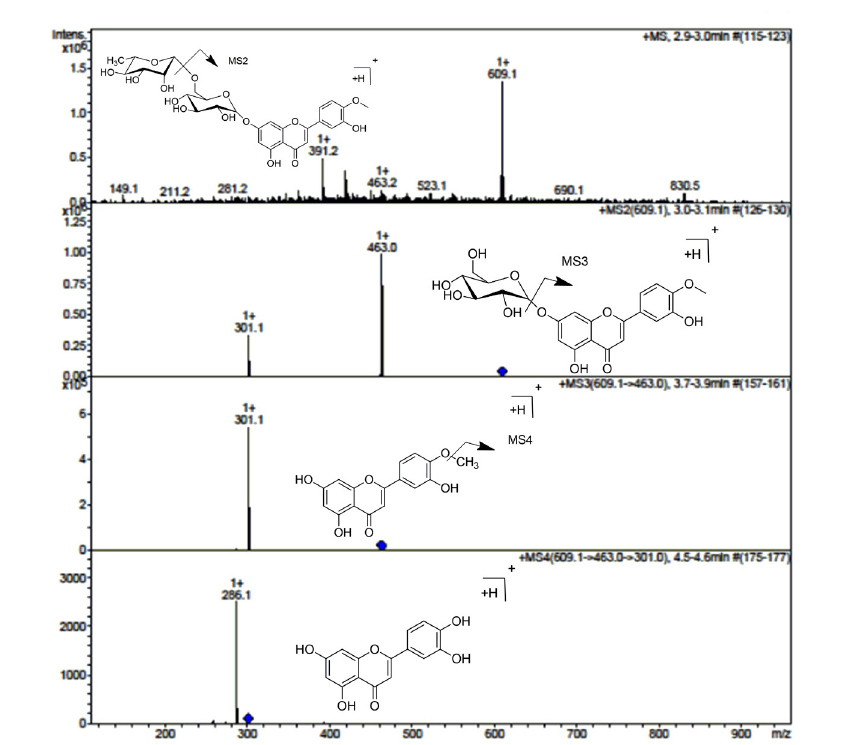
FIGURE 4 - ESI-MSn spectrum (positive ion mode) of diosmin ( 20 ), and proposed fragmentation pattern.